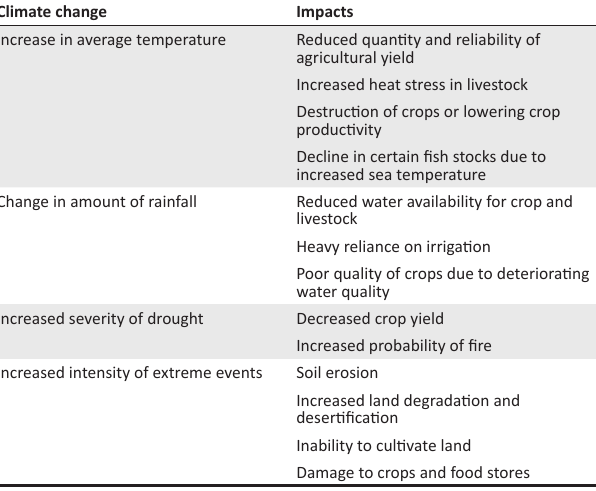
TABLE 2: The Impact of climate change on food security. Climate change